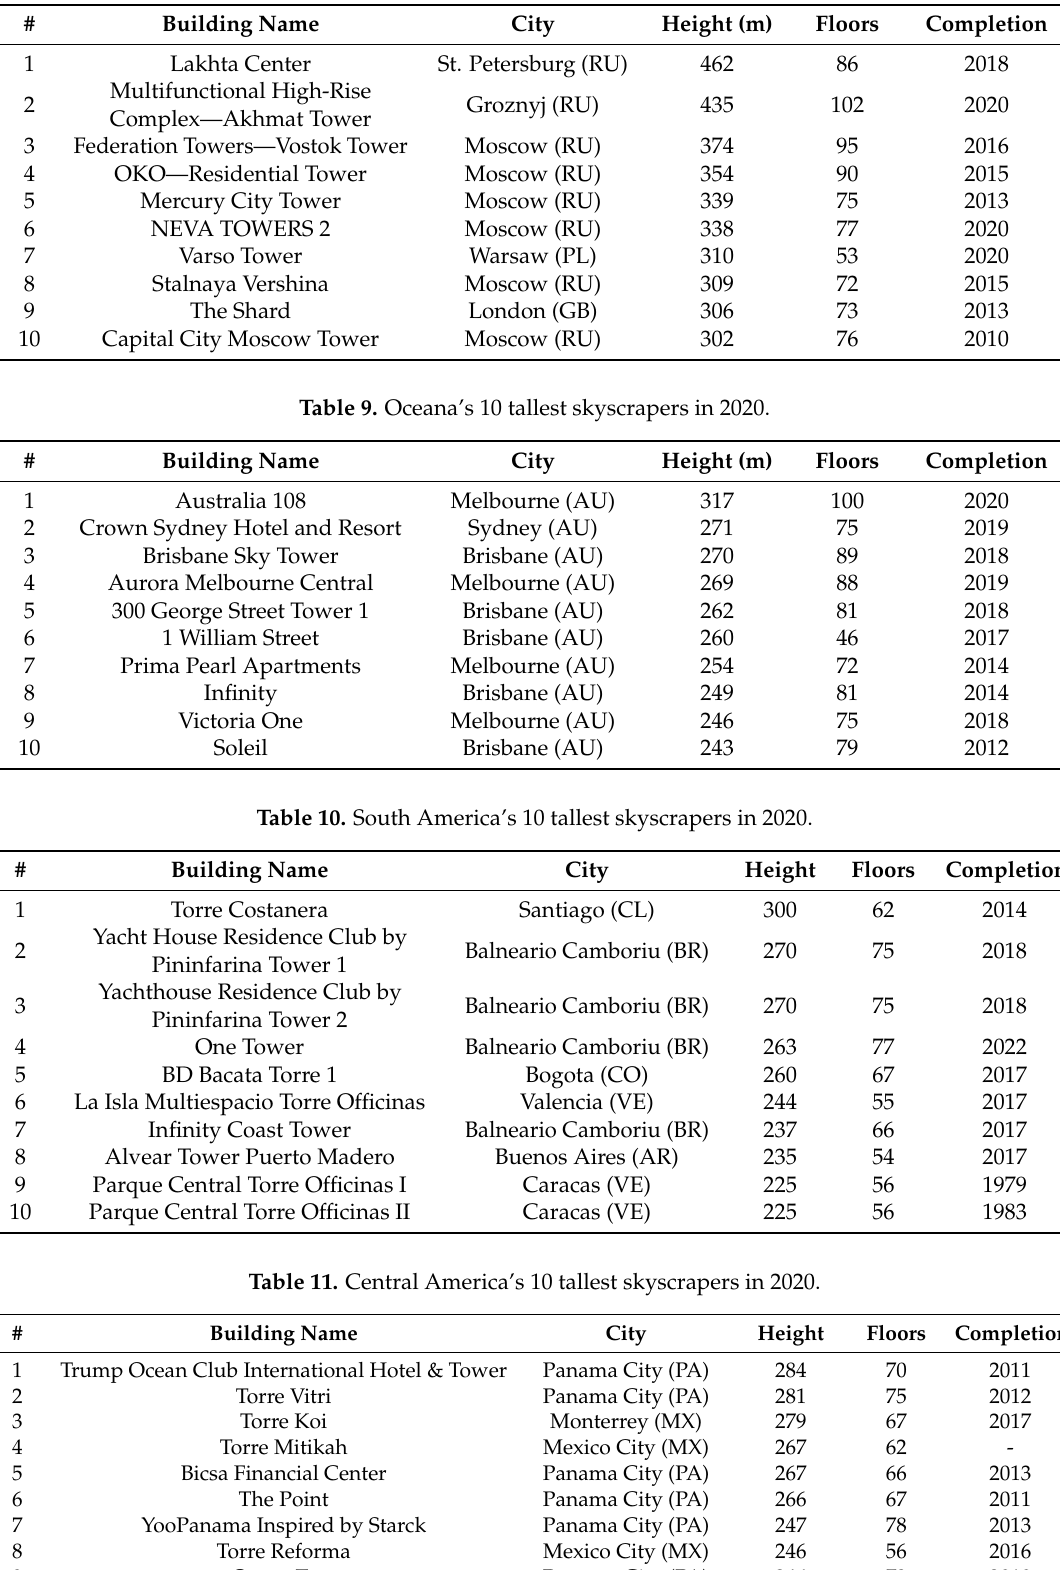
Table 8. Europe’s 10 tallest skyscrapers in 2020.